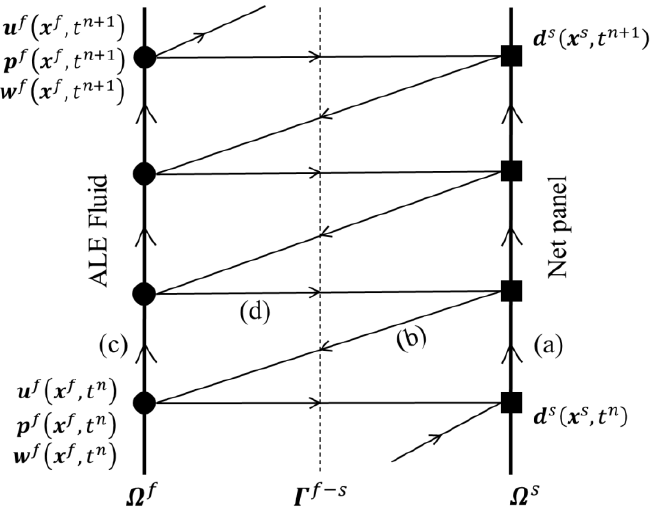
Figure 1. Schematic of predictor–corrector procedure for ALE fluid and net panel coupling: ( a ) Solve structural displacement; ( b ) transfer predicted structural displacement, where u f = u s = w f and update the fluid dynamic mesh; ( c ) solve ALE fluid equations and ( d ) forces corrections.